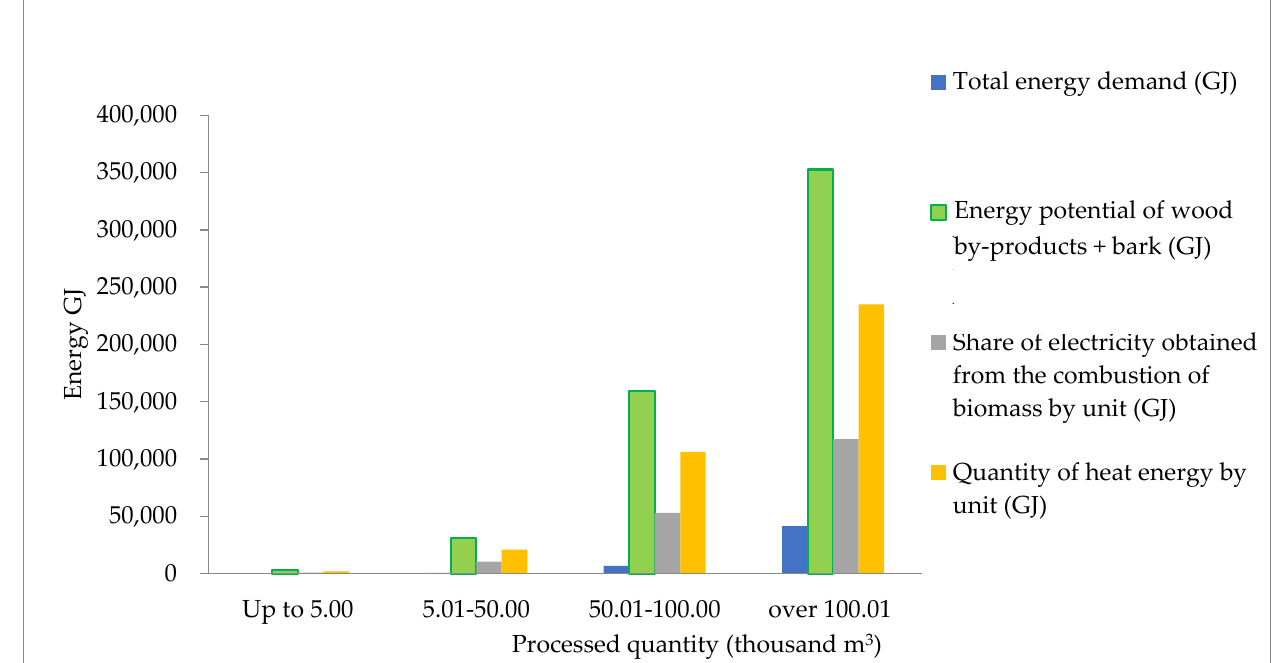
Figure 3. The ratio of electricity demand and potential use of biomass for energy and heat purposes.